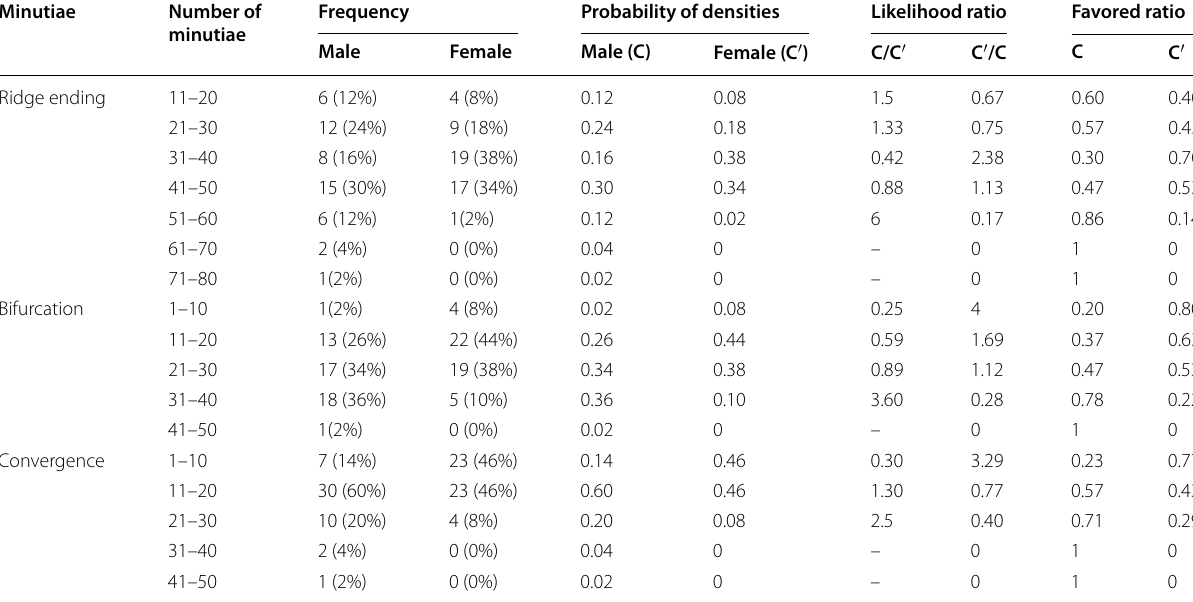
Table 7 Probability of proportions, likelihood ratio, and favored odds of male and female in left hand